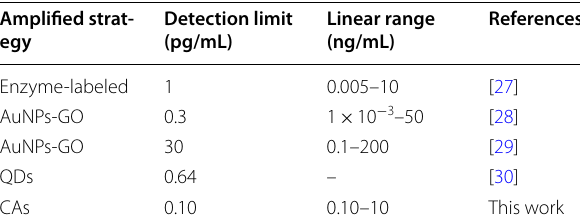
Table 2 The detection of OTA in the spiked corn sample Sample Spiked